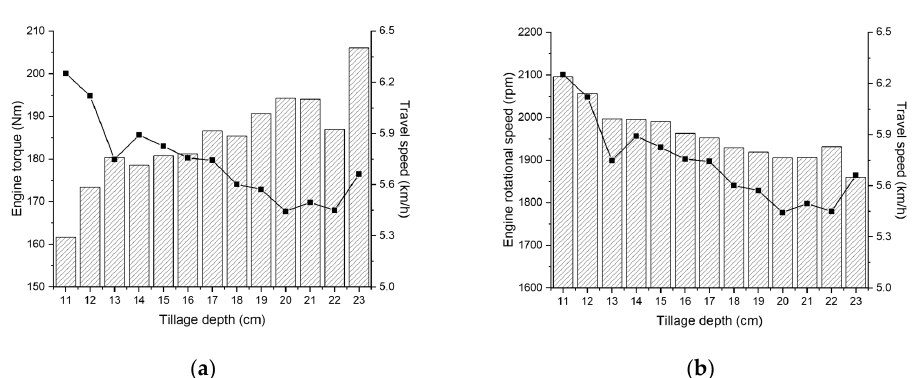
Figure 9. Overall mean ( a ) engine torque, and ( b ) rotational speed of agricultural tractor according to tillage depth during moldboard plowing.